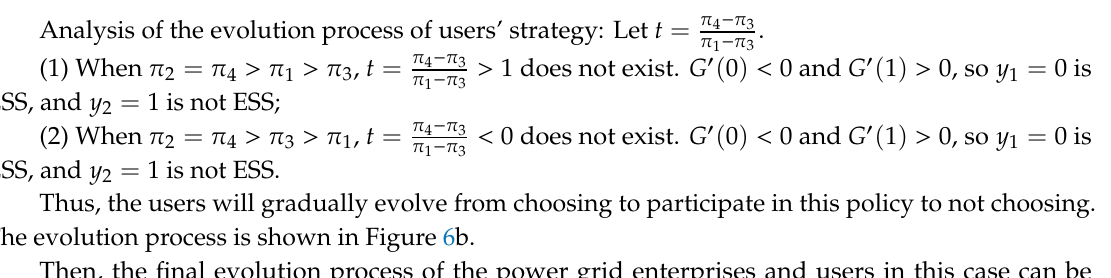
Figure 6. Analysis of the evolution process in Case 2. ( a ) Power grid companies; ( b ) users; and ( c ) power grid companies and users.